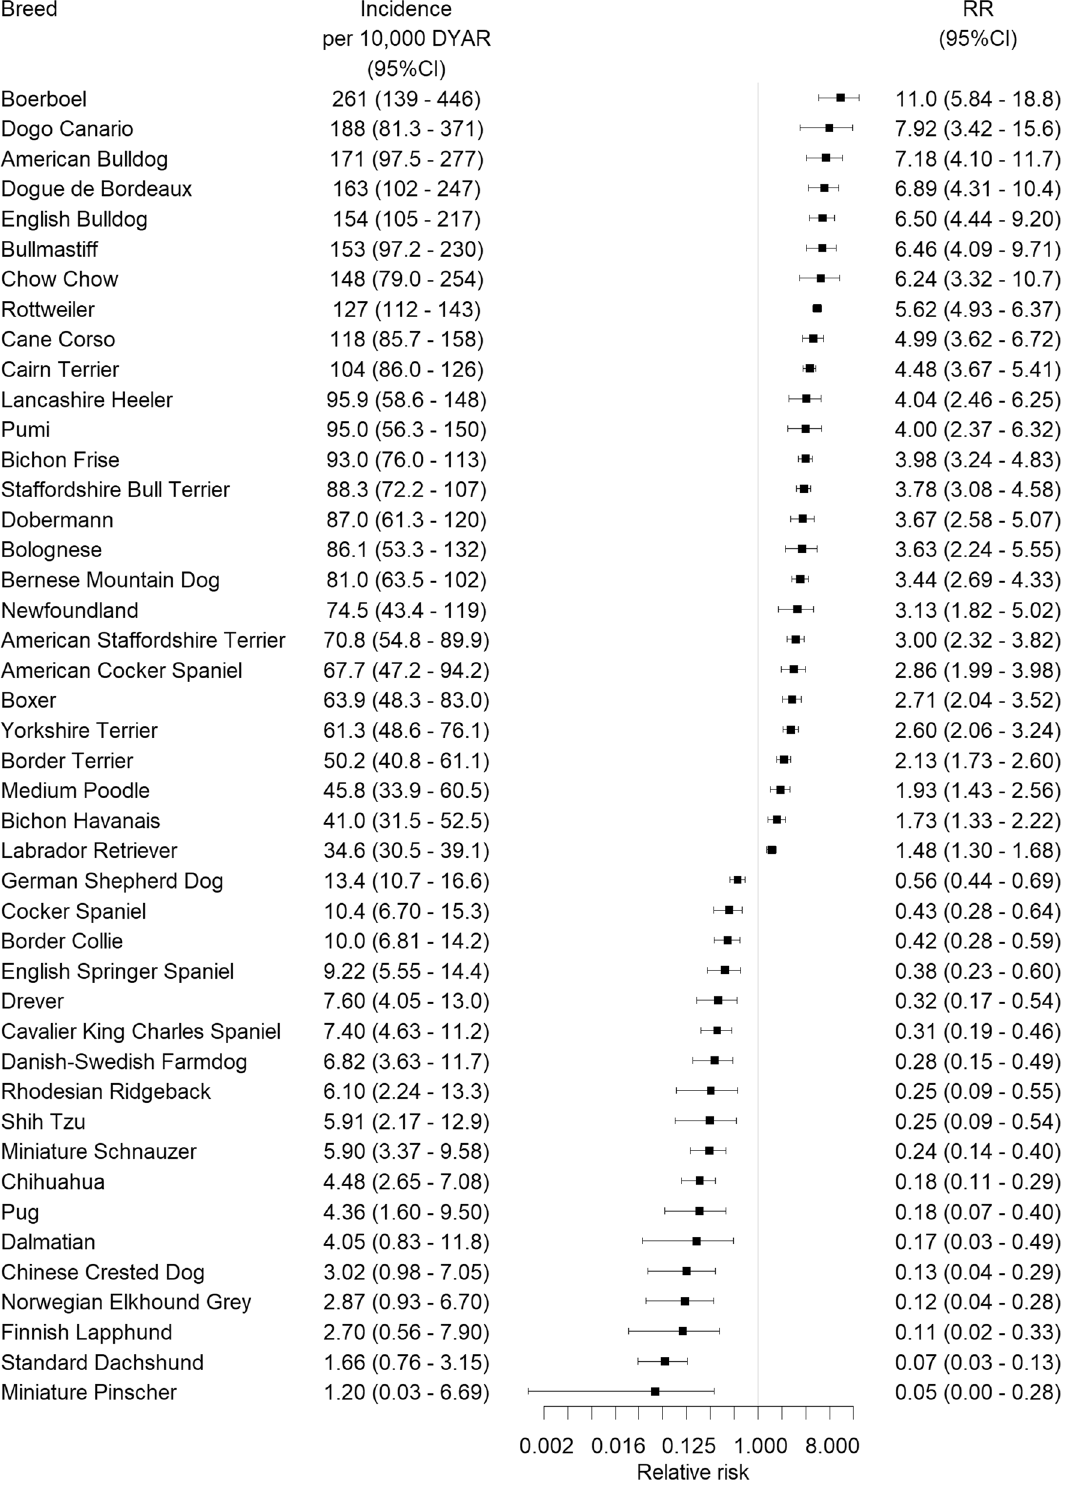
Figure 1. Dog breeds with increased or decreased relative risk (RR) of a veterinary care claim for cruciate ligament rupture (relative to the rest of the population with the breed excluded) in a cohort of dogs insured in Agria Pet Insurance in Sweden (2011–2016). All RRs in the figure were significantly different from 1, after Bonferroni correction based on the number of breeds included in the comparison, n = 339. Note that RR = 0.5 means 2 times decreased risk, RR 0.125 means 8 times decreased risk and so on. DYAR dog-years at risk, CI confidence